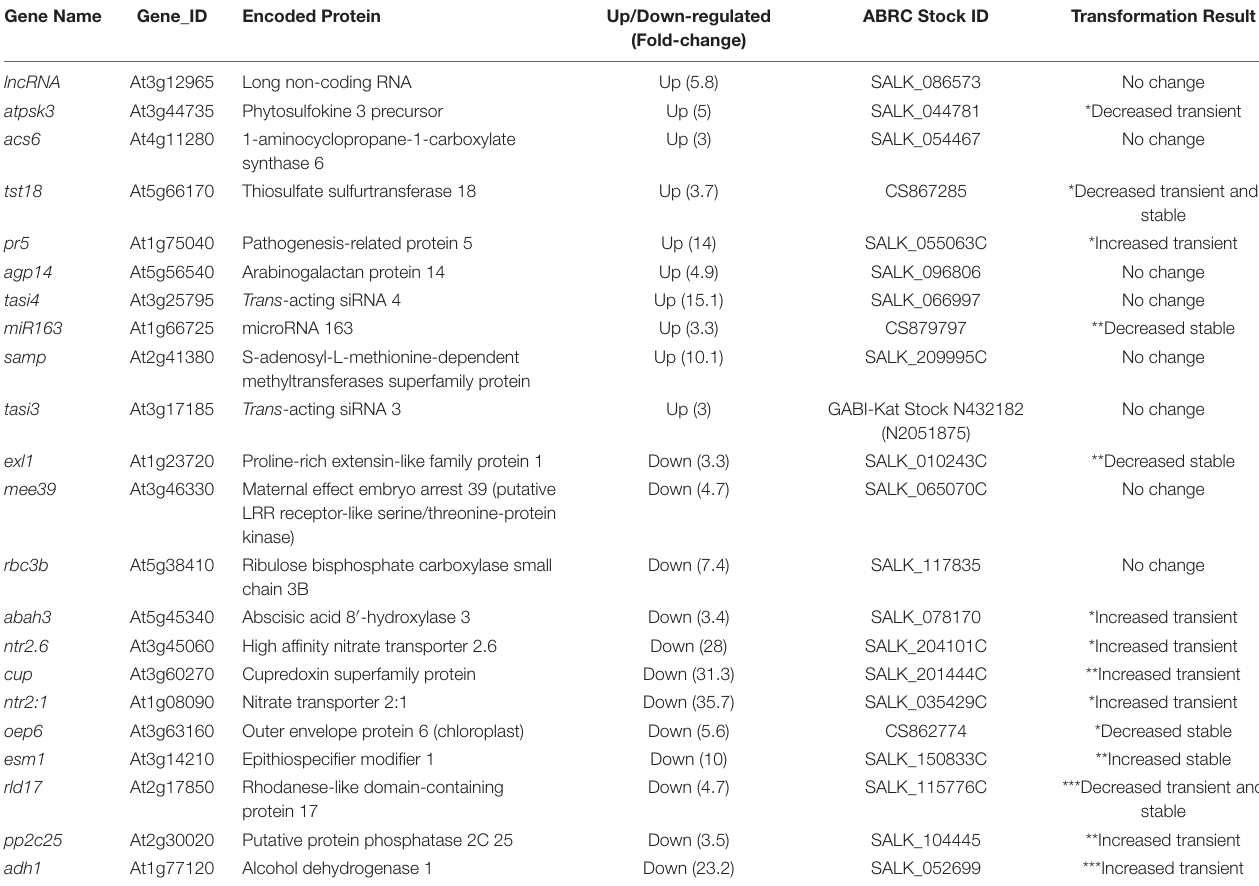
TABLE 2 | Transformation phenotypes of mutants of VirE2 differentially expressed genes.